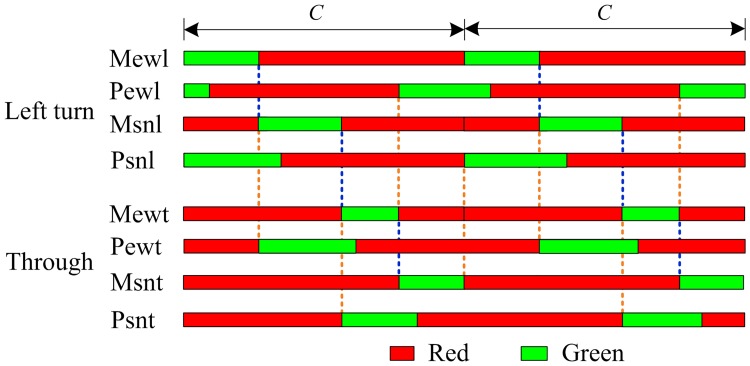
The intersection phasing scheme without intergreen time.